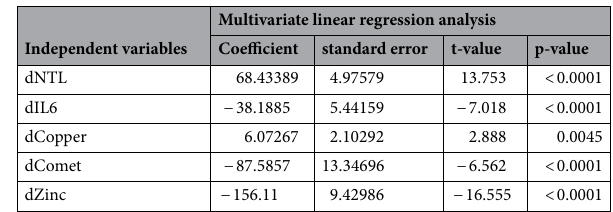
Table 3. Multivariate multiple linear regression analysis of the relative variation of the selected biomarkers for predicting the dose group in Gy.